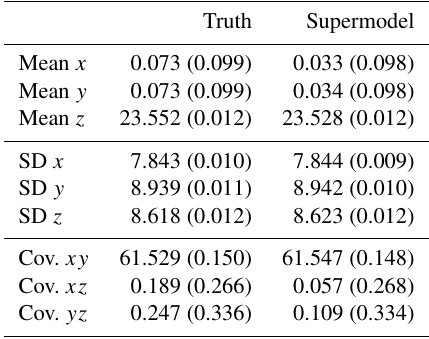
Figure 4. Measure of the forecast quality. At times t i a short inte- gration of time T starts from observed initial conditions and slightly Figure 3. Trajectory of the supermodel (blue), together with the perturbed conditions. The fixed time interval between times t i is de- true trajectory (green). noted by d . Table 3. Parameter values of the truth and the supermodel. Table 4. The mean, standard deviation (SD) and covariance for the truth and the supermodel. The 95% error estimation is given σ ρ in